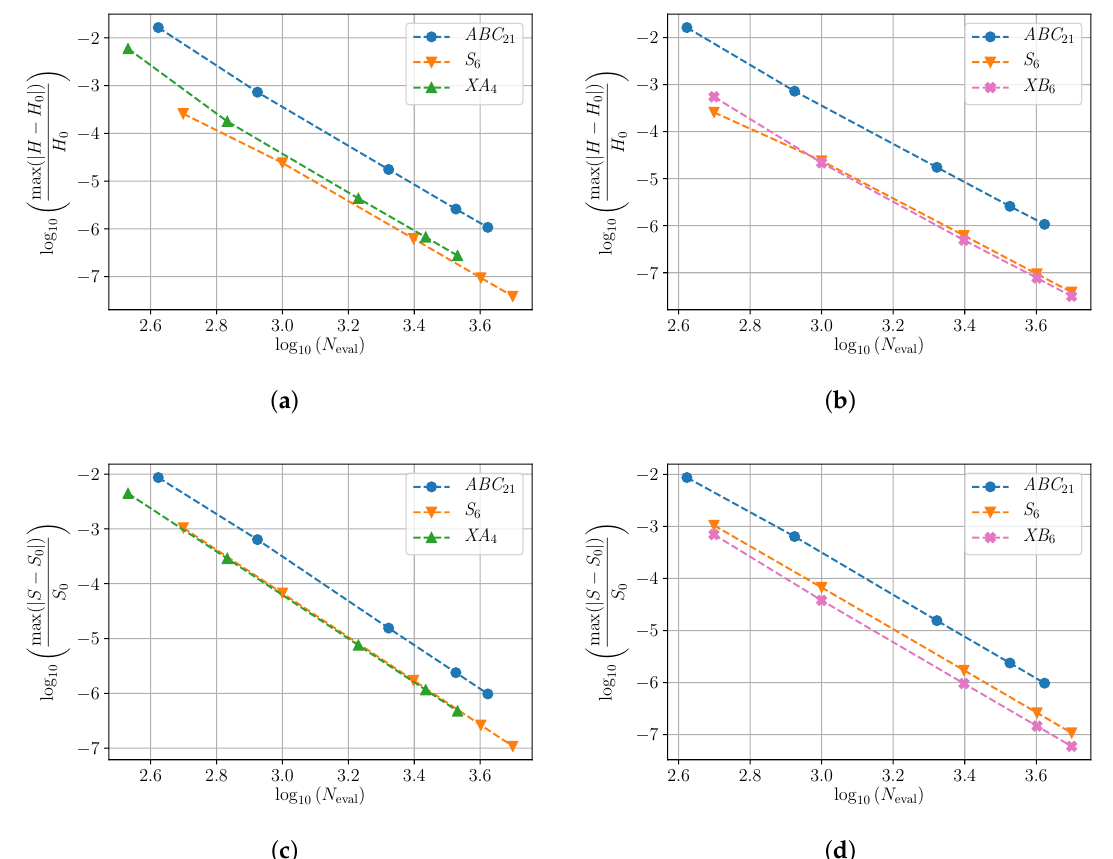
Figure 3. Relative error in conserved quantities for the DDNLS system due to each of the best numerical methods tested. ( a ) Relative error in energy for XA 4 compared to ABC 21 and S 6 . ( b ) Relative error in energy for XB 6 compared to ABC 21 and S 6 . ( c ) Relative error in norm for XA 4 compared to ABC 21 and S 6 . ( d ) Relative error in norm for XB 6 compared to ABC 21 and S 6 .